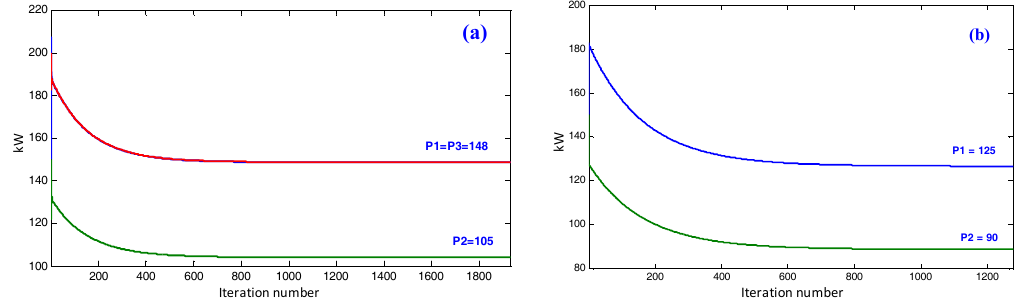
Figure 18. Operation results of isolated part using consensus algorithm: ( a ) Case 1; and ( b ) Case 2.